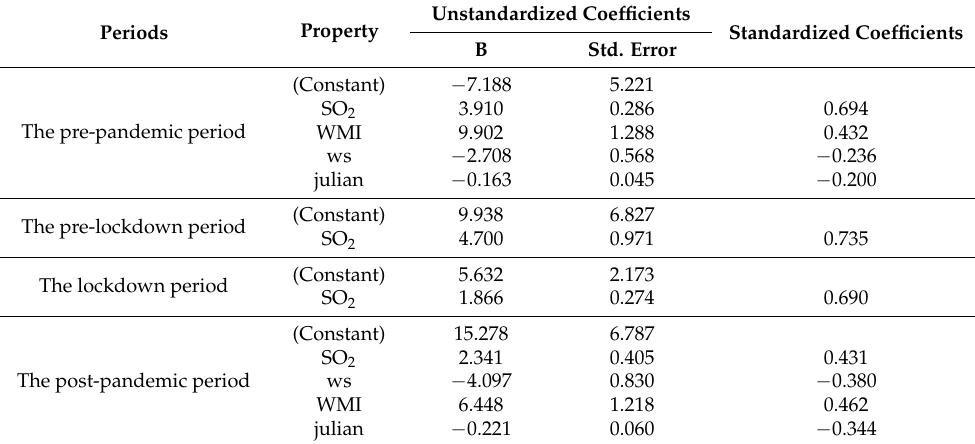
Table 4. Regression coefficients of stepwise multiple linear models over four